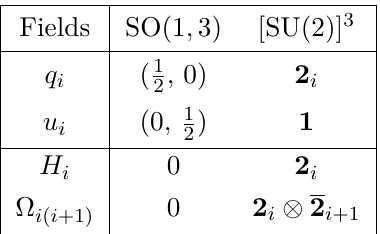
Table 1 . Matter field content of the minimal three-site